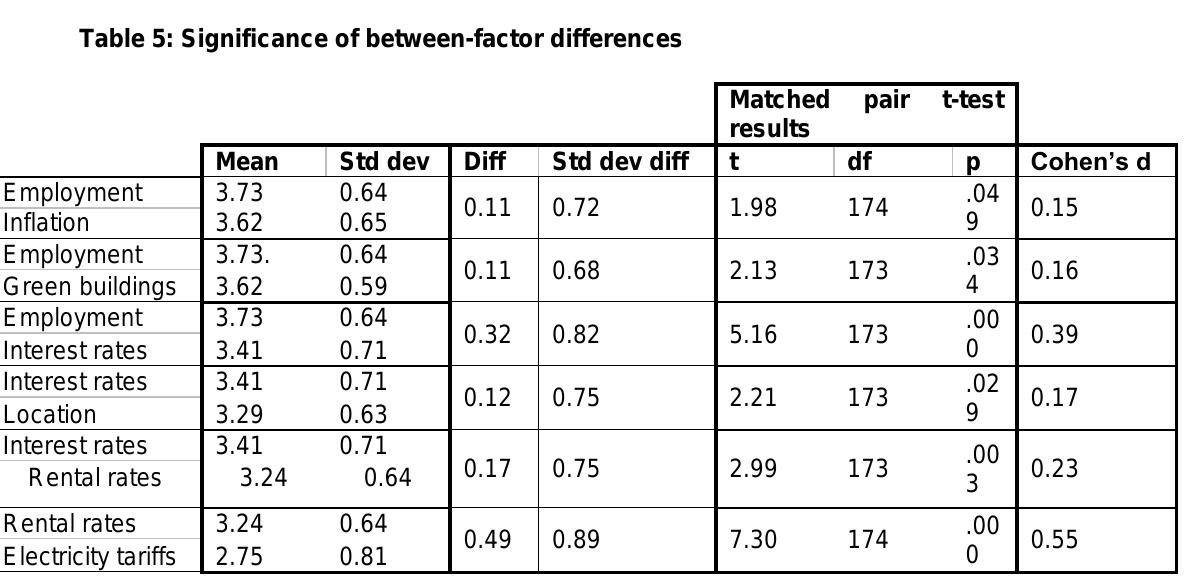
Table 5: Significance of between-factor differences